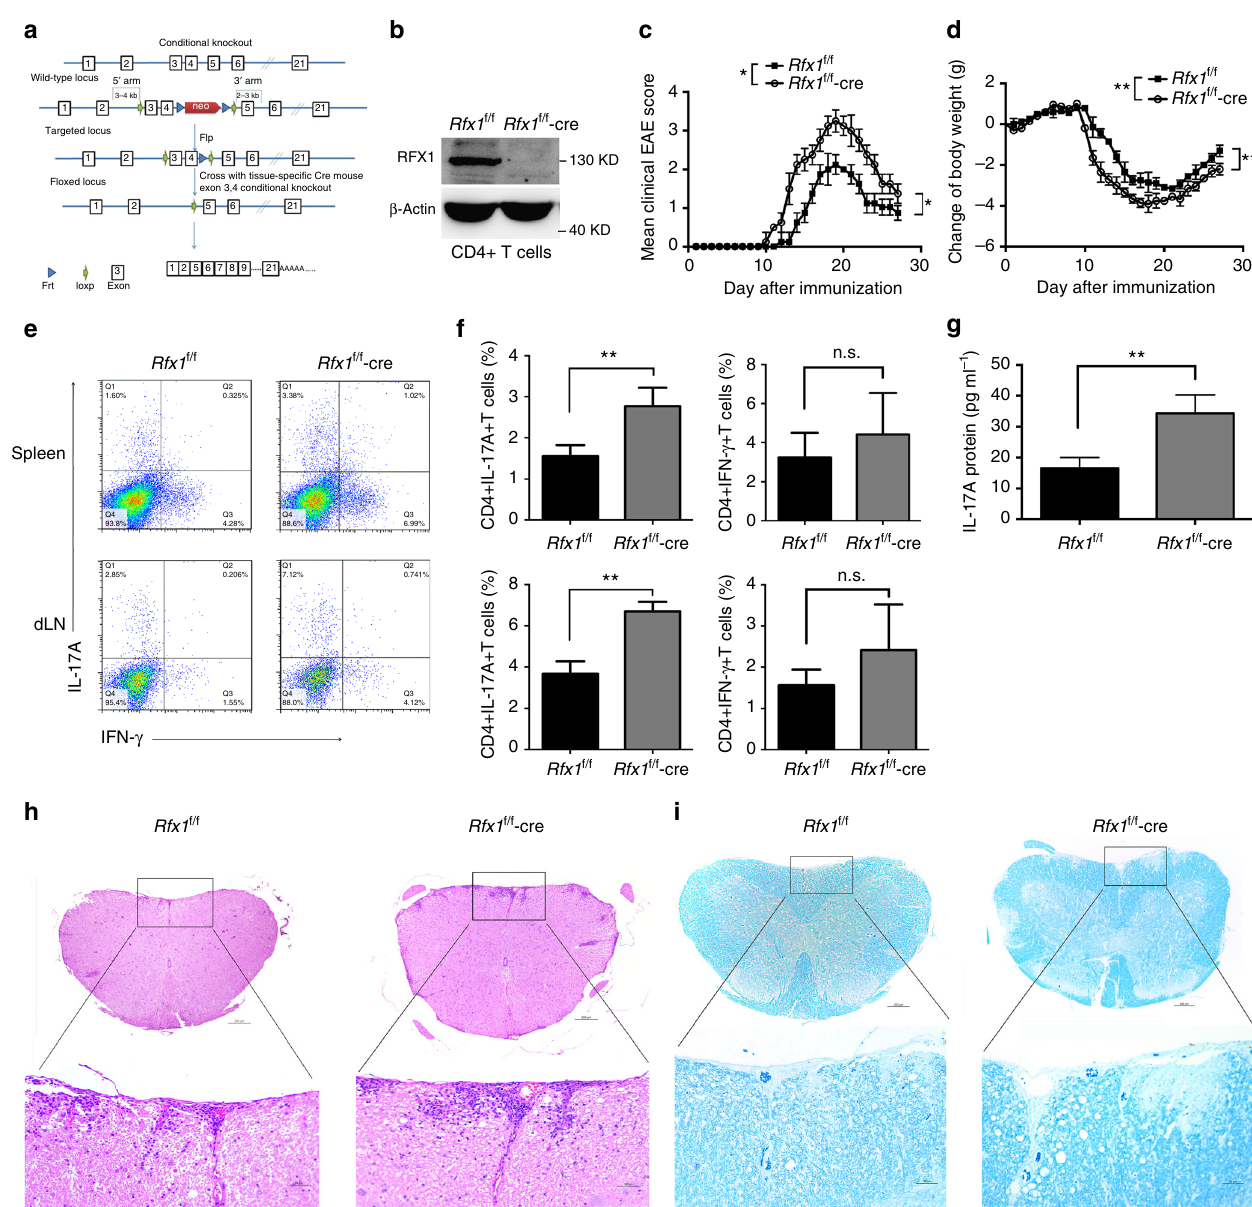
Fig. 5 EAE is aggravated in Rfx1 cKO mice. a Schematic representation of the Rfx1 locus and targeting strategy. Cre-mediated recombination of loxP sites in mice. Exon 3 and 4 of Rfx1 were knocked out in Rfx1 f/f by CD4-cre, which was named after Rfx1 f/f -cre (cKO). b Representative western blot analysis of RFX1 protein expression in CD4 + T cells of Rfx1 f/f -cre and control Rfx1 f/f ( n = 3 mice per group). c , d Clinical scores and weight loss of Rfx1 f/f or Rfx1 f/f -cre mice after the induction of EAE were assessed every day ( n = 5 mice per group). e , f Flow cytometric analysis of the percentages of CD4 + IL-17A + T cells and CD4 + IFN- γ + T cells in the spleens and draining lymph nodes (dLN) derived from Rfx1 f/f or Rfx1 f/f -cre mice ( n = 5 mice per group). g The concentration of IL- 17A protein in serum from Rfx1 f/f and Rfx1 f/f -cre mice with EAE was measured by ELISA ( n = 5 mice per group). h In fi ltrating lymphocytes in the spinal cord of Rfx1 f/f and Rfx1 f/f -cre mice with EAE were analyzed by H&E staining. i The degree of demyelination of spinal cords from Rfx1 f/f and Rfx1 f/f -cre mice with EAE was analyzed by luxol fast blue staining ( n = 5 mice per group). Scale bars, 200 or 50 μ m (magni fi ed panels). Data are shown as mean ± s.d. * P < 0.05; ** P < 0.01; n.s., not signi fi cant, two-way analysis of variance and Mann – Whitney U -test (two-tailed) for c , d , and two-tailed Student ’ s t -tests for f ,